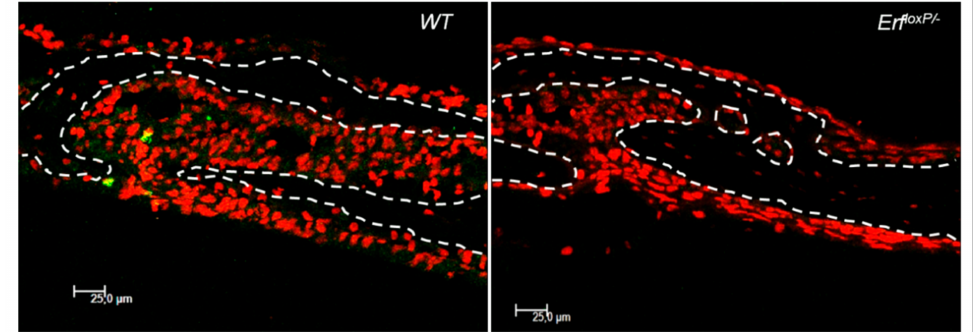
Figure 16. Confocal microscopy ( × 63 magnification) of coronal sutures transverse cryosections from P15 mouse calvaria stained with BrdU (green) to evaluate cellular proliferation and TOPRO-3 (red) to identify the nuclei. Dotted lines indicate the position of the parietal and frontal